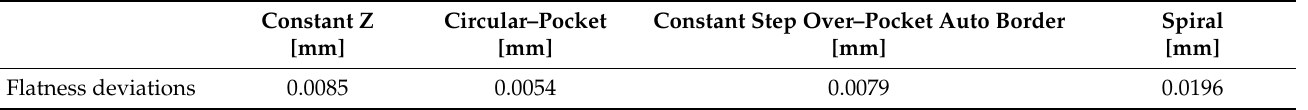
Table 6. Flatness deviations for individual parts.